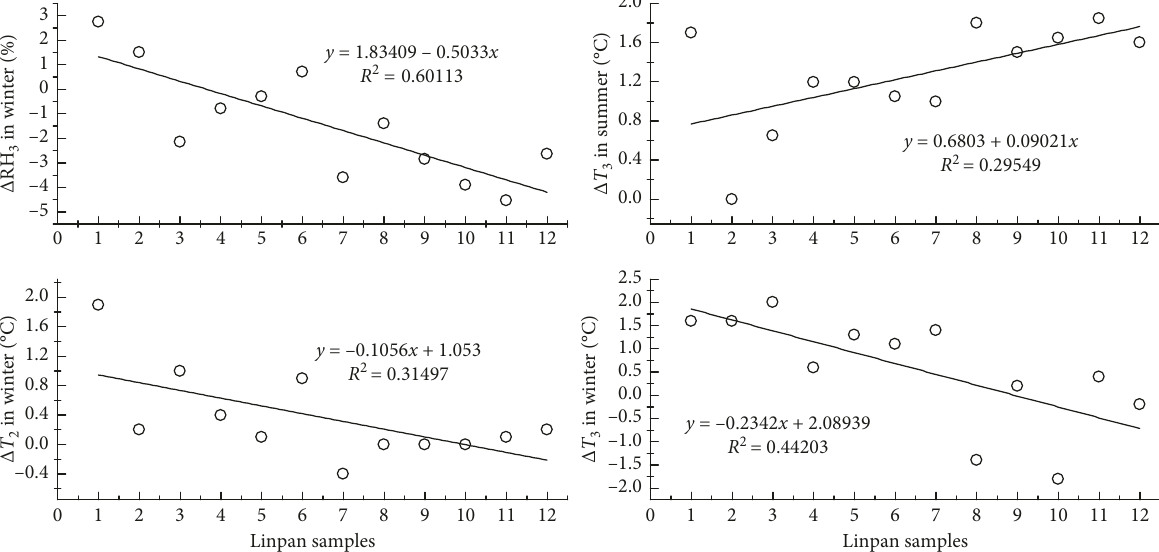
Figure 10: The linear relationship between Linpan size and micrometeorology